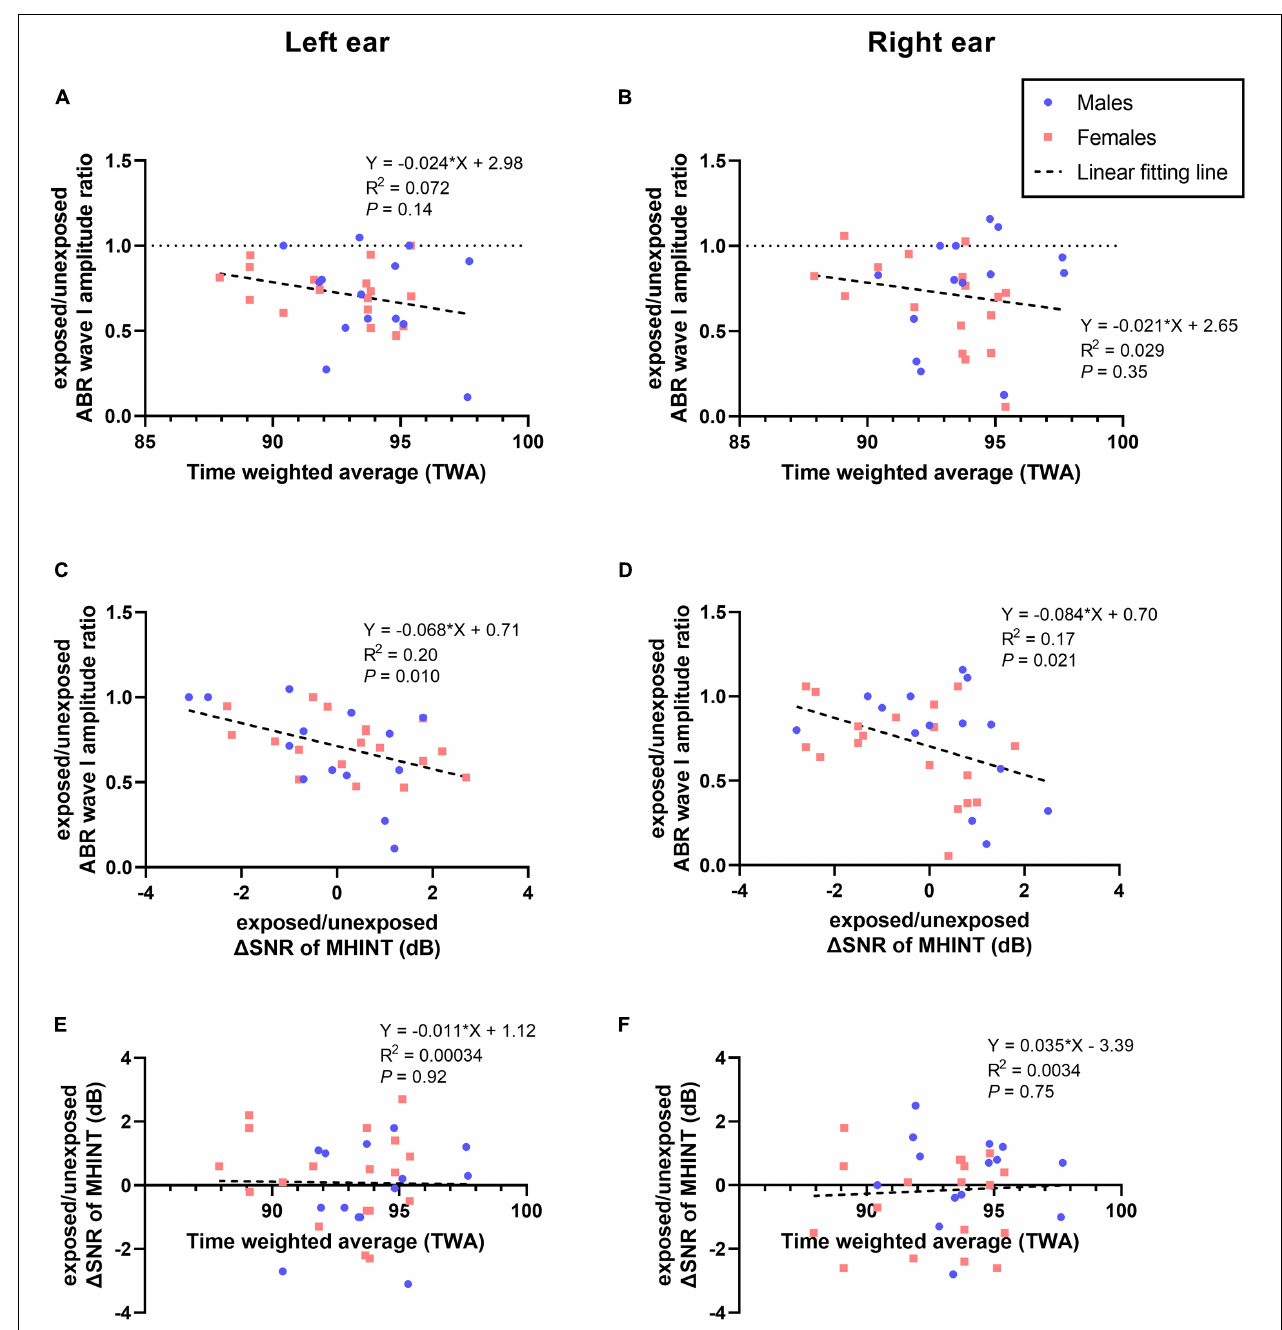
FIGURE 7 | Correlations of noise exposure, ABR wave I, and MHINT. Neither the exposed/unexposed ABR wave I amplitude ratio (A,B) nor the SNR changes ( (cid:49) SNR) of the MHINT (E,F) significantly correlated with time-weighted average (TWA) noise exposure, whereas the exposed/unexposed ABR wave I amplitude ratio significantly correlated with the (cid:49) SNR of MHINT (C,D) for the left ear and right ear. Males are in blue, females are in pink, and lines of fit for the overall sample are in